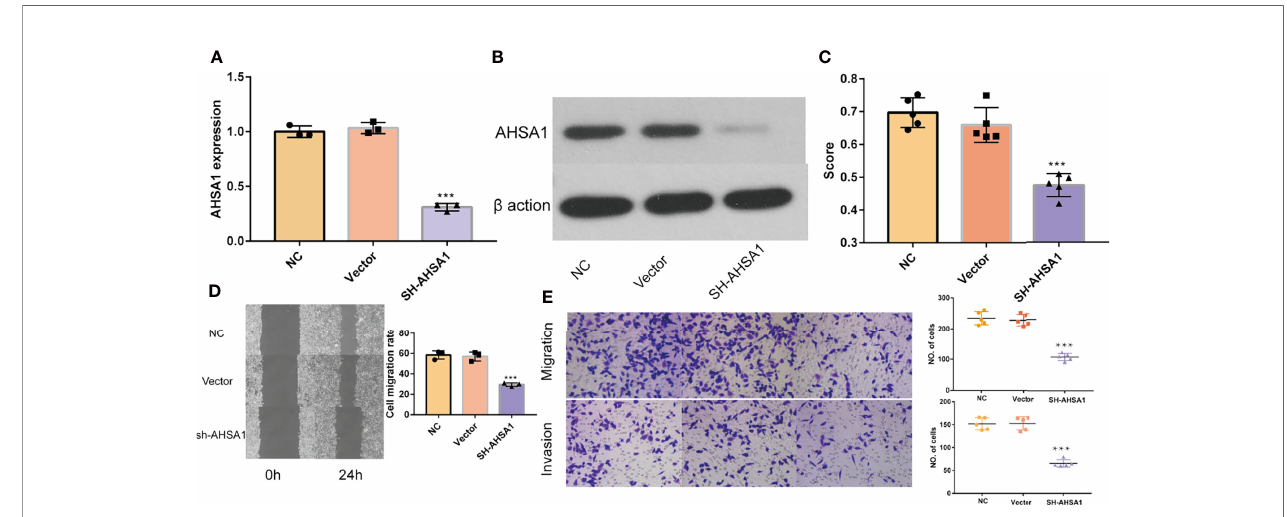
FIGURE 9 | Effects of AHSA1 knockdown on HCCLM3 cell proliferation and migration. Real time PCR (A) and Weston blot (B) determine the ef fi ciency of AHSA1 knockdown in Huh7 cells. (C) CCK8 assays was performed to detect the cell proliferation of HCCLM3. (D) Scratch test was used to determine the cell migration. (E) Cell migration and invasion was detected by Tranwell assay.